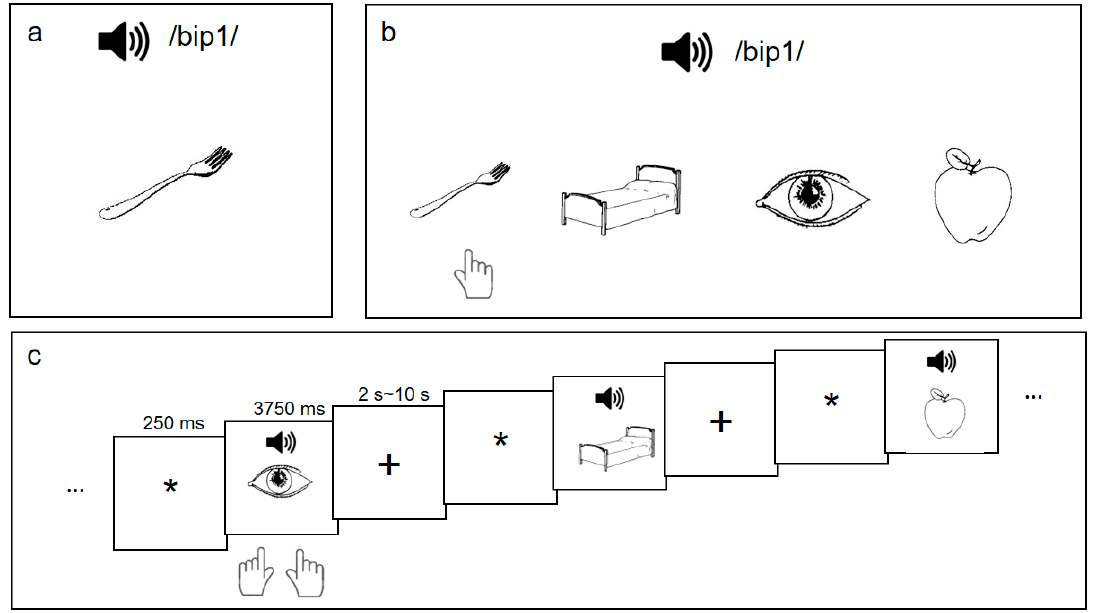
Figure 1. Participants were trained on 48 sound-picture associations ( a ) and were asked to complete a recognition test with feedback ( b ) after each training session. After the six-week L2 vocabulary training, they performed a sound-picture association judgment task ( c ) when their brain images were collected.